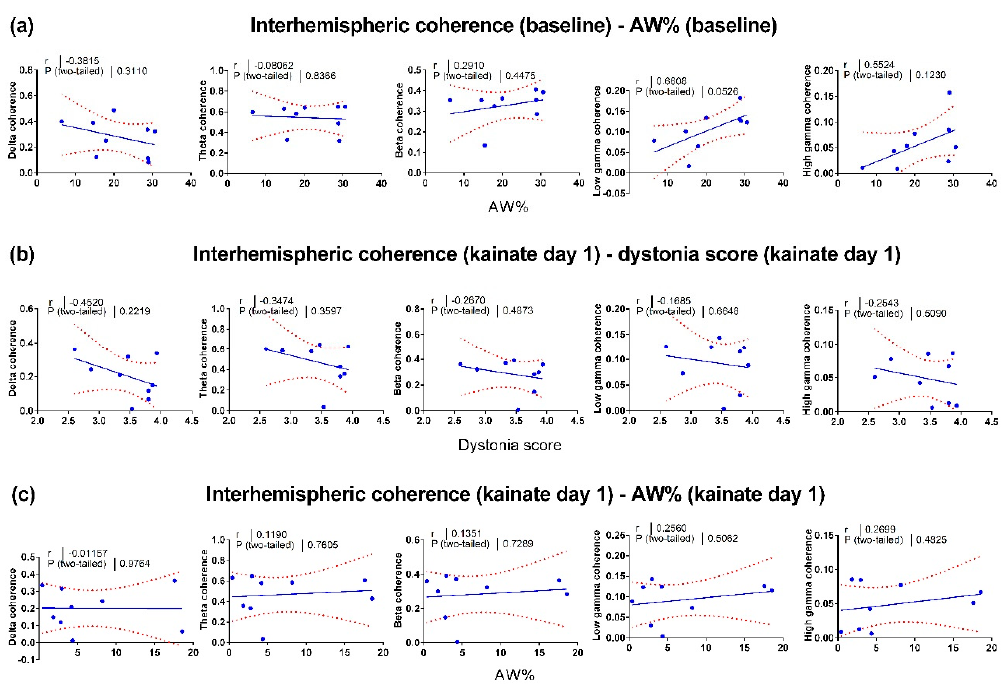
Figure 4. Pearson correlations between left and right motor cortices interhemispheric coherence and behavior in baseline and the first day of cerebellar kainate application. ( a ) Linear regression of active wake percentage in baseline day versus interhemispheric coherence (delta, theta, beta, low gamma, high gamma bands). ( b ) Linear regression of dystonia score versus interhemispheric coherence (delta, theta, beta, low gamma, high gamma bands) in kainate day 1. ( c ) Linear regression of active wake percentage versus interhemispheric coherence (delta, theta, beta, low gamma, high gamma bands) in kainate day 1. Each point corresponds to one subject. The plain and dotted curves denote the 95% tolerance and confidence intervals of the linear regression, correspondingly. R and p values are indicated above on each graph. Figure 5. Pearson correlations between left and right motor cortices (interhemispheric) coherence and behavior on the fifth day of cerebellar kainate application. ( a ) Linear regression of dystonia score in kainate day 5 versus interhemispheric coherence (delta, theta, beta, low gamma, high gamma bands). ( b ) Linear regression of active wake percentage versus interhemispheric coherence (delta, theta, beta, low gamma, high gamma bands) in kainate day 5. Each point corresponds to one subject. The plain